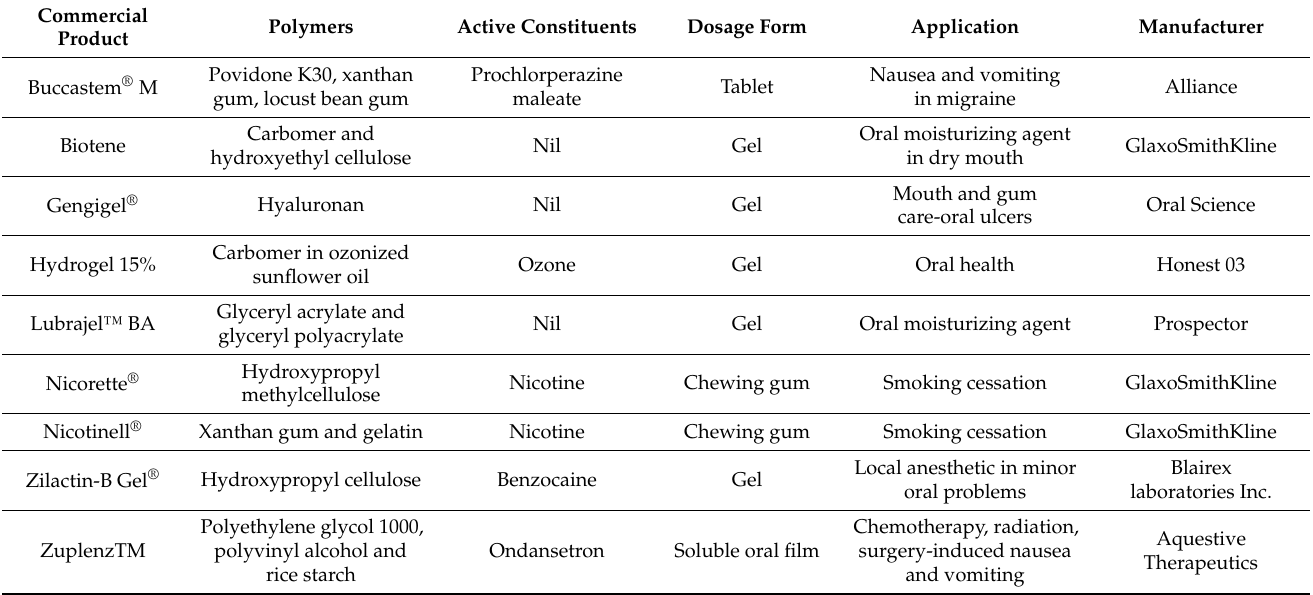
Table 3. Selected examples of hydrogel-based commercial dosage forms for oral delivery. Commercial